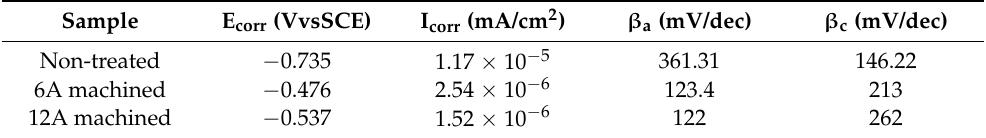
Figure 8. Polarization diagrams of the EDA machined surface with different peak current and the non-treated counterpart. Table 3. Electrochemical linear polarization parameters of the EDA machined surface with different peak current along with the non-treated counterpart. β a: anodic tafel slope, β c: cathodic tafel slope.